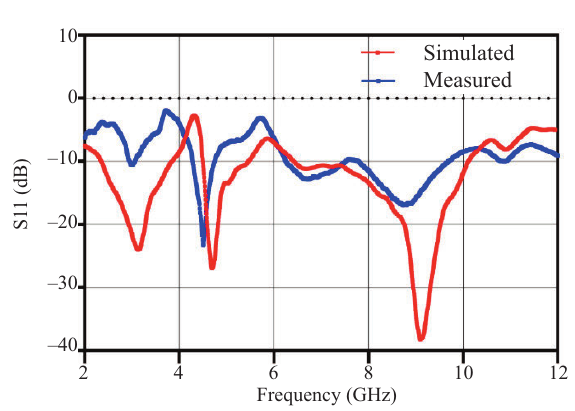
Fig. 11. The S11 measurement and simulation for the designed